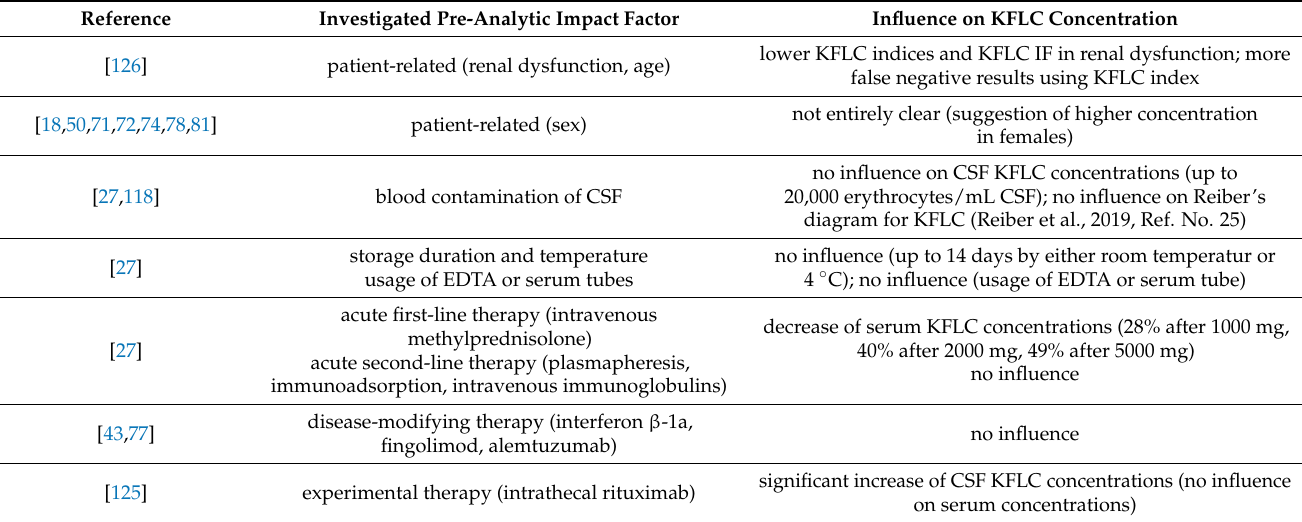
Table 1. Influence factors on kappa free light chain (KFLC)